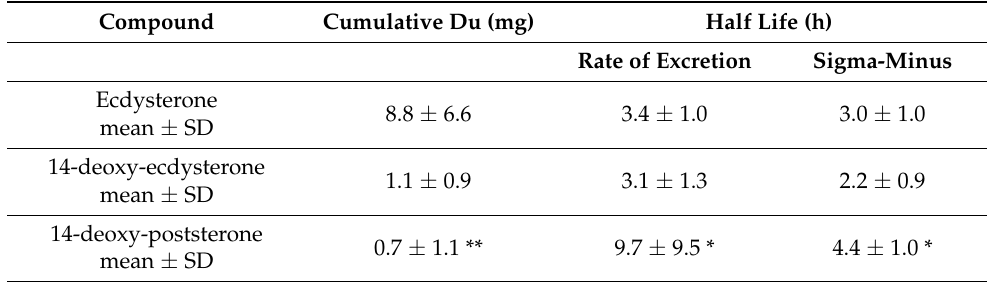
Table 6. Urinary pharmacokinetic parameters calculated as the mean of 12 subject ± standard deviation (SD), after administration of a single dose of 50 mg of pure